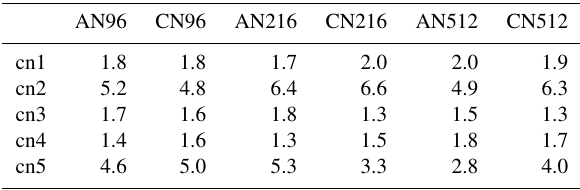
Table 2. Root-mean-square deviation of monthly precipitation re- cycling ratio (%) measured between MetUM simulations and ERA- Interim over five EA